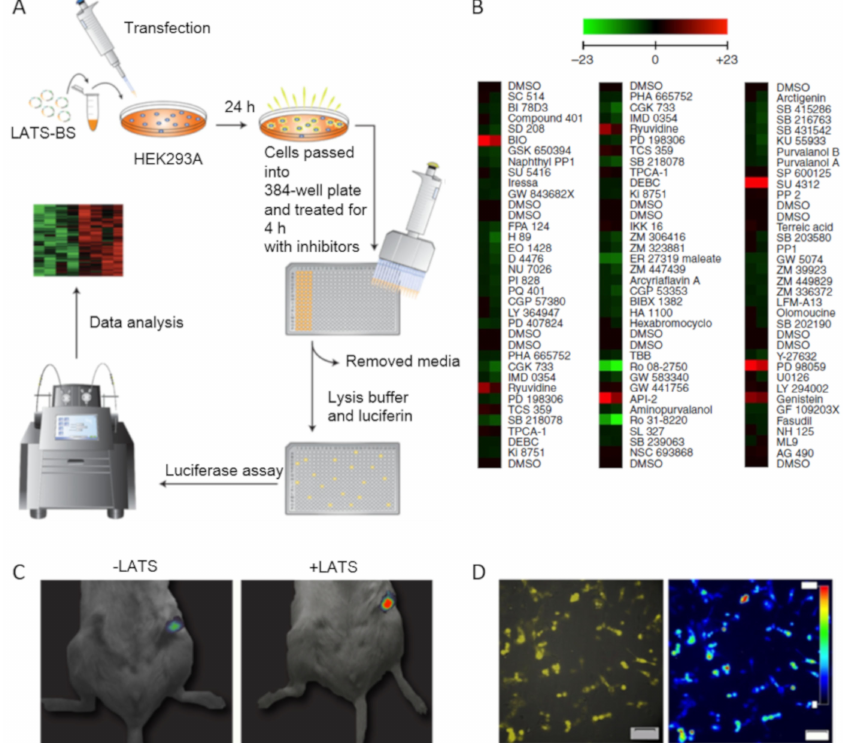
Figure 3. LATS-BS application to several experimental models. ( A ) Experimental design for high- throughput kinase inhibitor screen. Cells were transfected with LATS-BS, treated with a kinase inhibitor library, and luciferase assay was performed on cell lysates. ( B ) Heat map summarizing the results of the kinase inhibitor screen. Drugs that activate LATS-BS are shown in red, drugs that inhibit LATS-BS are shown in green. ( C ) LATS-BS was tested for in vivo imaging. HEK293 cells were transfected with LATS-BS only (-LATS) or LATS-BS and LATS kinase, injected into the mammary fat pad of immunocompromised mice, and bioluminescence was measured. ( D ) LATS-BS was used for bioluminescent imaging of LATS activity in live cells (MDA-MB231 cell line). The figures were taken from Azad et al. with minor changes